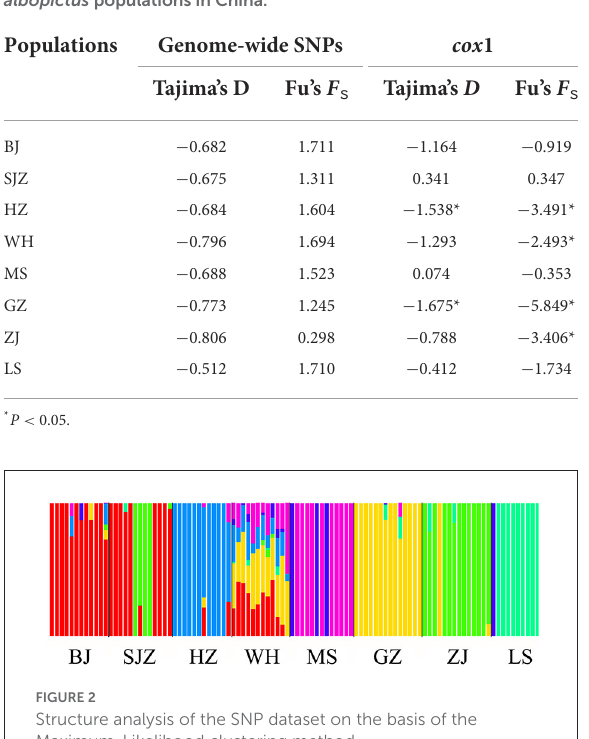
TABLE 3 Neutrality tests based on genome-wide SNPs and cox 1 of Ae. albopictus populations in China.